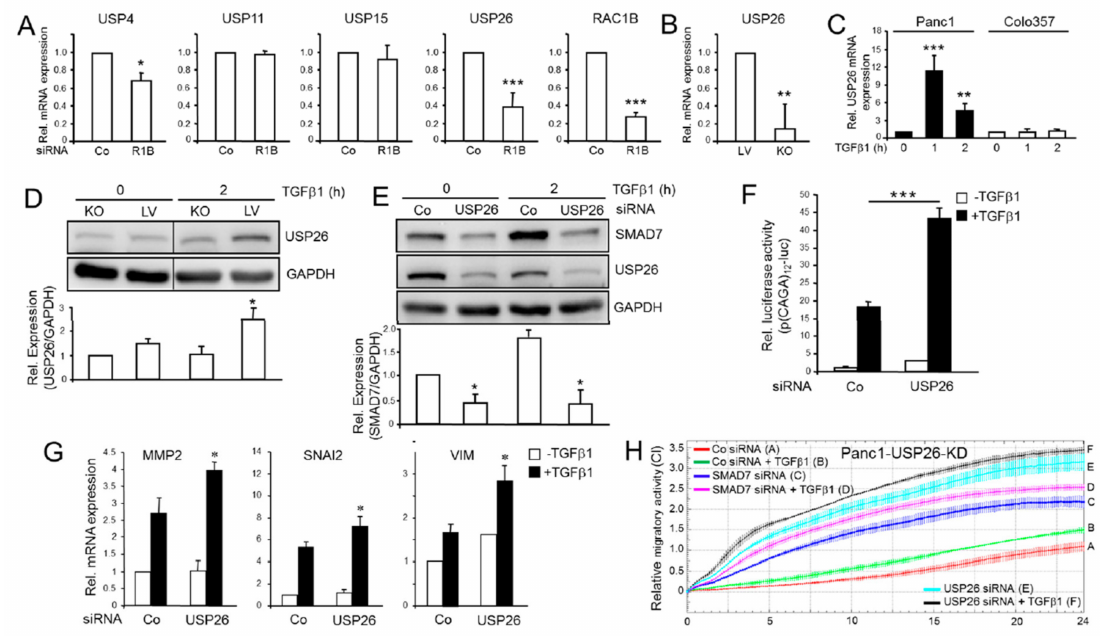
Figure 8. E ff ect of modulating USP26 expression on SMAD7, TGF β 1-induced transcriptional activity, target gene expression, and cell migration. ( A ) Panc1 cells were transiently transfected with control (Co) siRNA or RAC1B siRNA and 48 h later subjected to qPCR analysis for the indicated USPs. Data are the mean ± SD of at least three independent experiments ( n = 3 for USP4, USP11 and USP15 and n = 7 for USP26 and RAC1B). ( B ) Cultures of Panc1-RAC1B-KO and LV cells were harvested at regular intervals and processed for qPCR analysis of USP26 (the mean ± SD, n = 5). ( C ) Panc1 or Colo357 cells were treated with TGF β 1 for the indicated times and USP26 mRNA levels determined by qPCR. Data are displayed as mean ± SD ( n = 3). ( D ) Panc1-RAC1B-KO and LV cells were stimulated with TGF β 1 for 2 h and processed for immunoblot analysis of USP26. The graph below the blot shows the results from quantification of band intensities (the mean ± SD, n = 3). ( E ) Panc1 cells were transiently transfected with Co siRNA or USP26 siRNA, stimulated with TGF β 1 for 2 h and processed for immunoblotting of SMAD7, USP26, and GAPDH as loading control. The graph depicts results from data quantification (the mean ± SD) of three assays. ( F ) Panc1 cells were transiently transfected with or Co siRNA or USP26 siRNA, along with p(CAGA) 12 -luc and pRL-TK-luc, treated with TGF β 1 for 24 h and subsequently processed for dual luciferase assay. Data are shown as the mean ± SD of six parallel wells from a representative experiment performed three times. The asterisk indicates significance ( p < 0.001, Mann–Whitney u test). ( G ) As in ( F ), except that reporter genes were omitted and cells subjected to qPCR analysis of MMP2 , SNAI2 , or VIM . Data were calculated from three experiments (the mean ± SD). ( H ) As in ( G ), except that Panc1 cells were subjected to real-time cell migration assay after transfection. Data are the mean ± SD of 3-4 wells and are representative of three experiments. Data are first significant at 01:00 and all later time points between USP26 siRNA + TGF β 1 and Co siRNA + TGF β 1 (black curve, tracing F vs. green curve, tracing B) and at 01:30 between SMAD7 siRNA + TGF β 1 vs. Co siRNA + TGF β 1 (magenta curve, tracing D vs. green curve, tracing B). The asterisks in ( A – E ) and ( G ) indicate significance (* p < 0.05, ** p < 0.01, *** p < 0.001, Wilcoxon test). The successful knockdown of USP26 is shown in panel